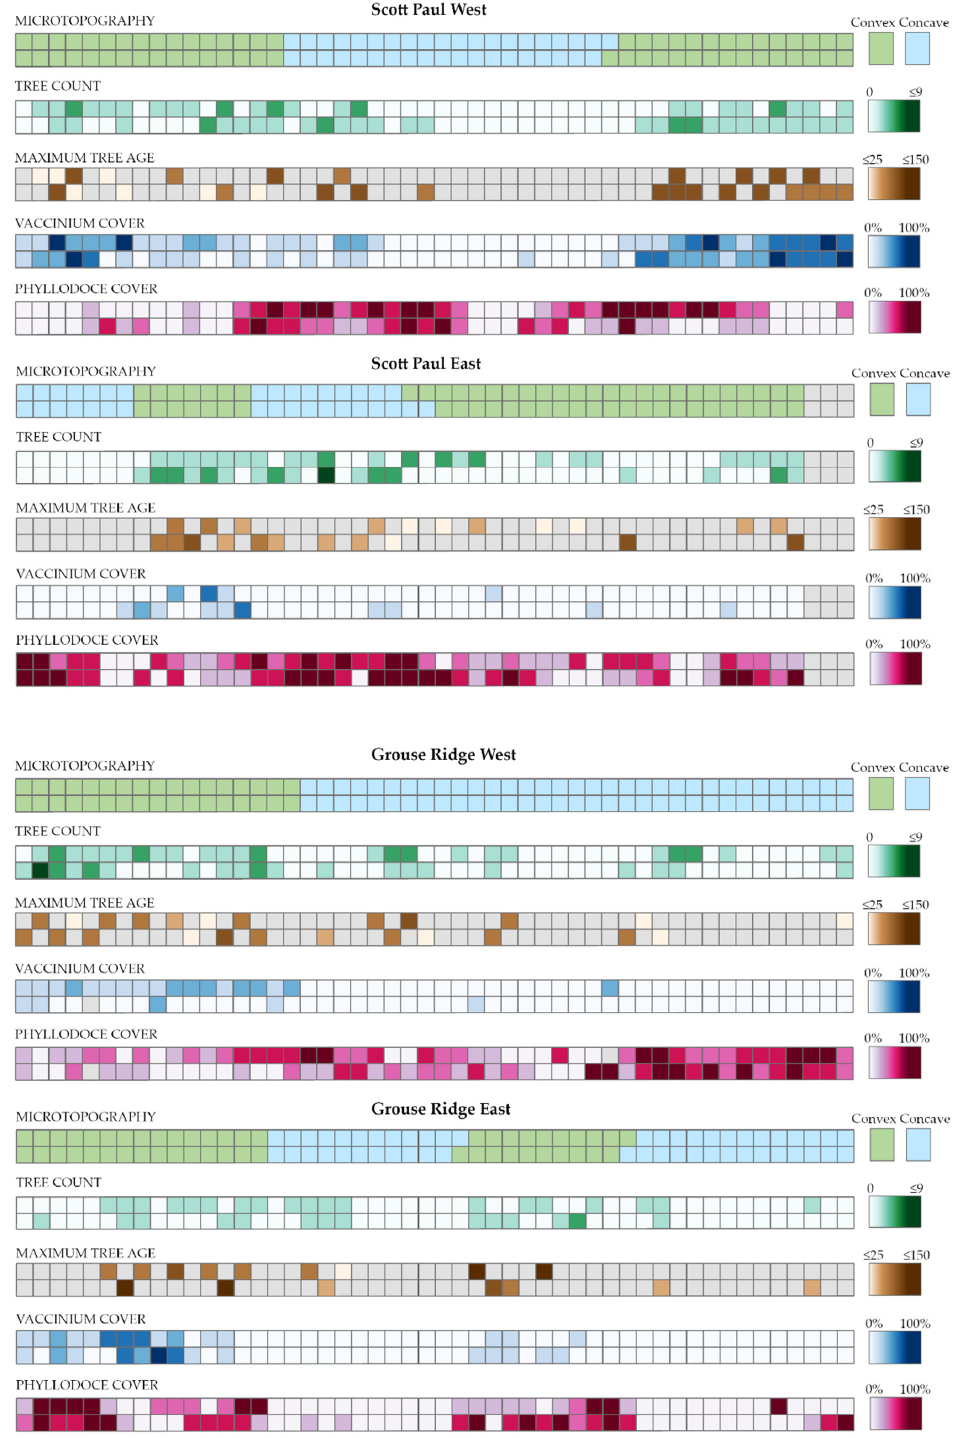
Figure 10. Spatial variables at each transect. Each grid cell corresponds to a square meter plot on a transect. Grid cells with no data for a particular variable are colored gray. Each transect begins at a seed source on the left side of the figure.